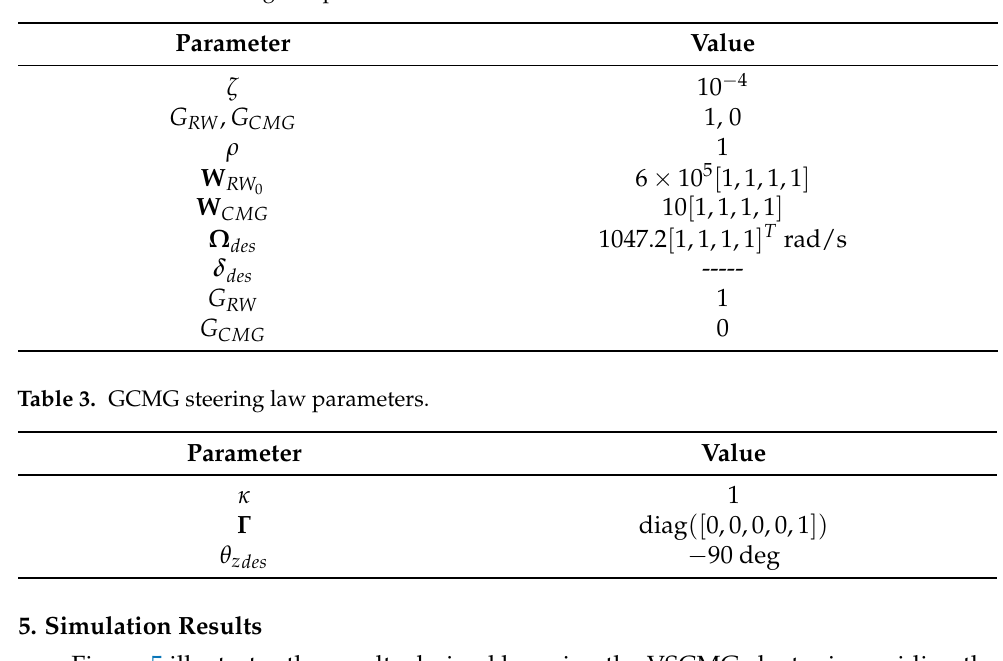
Table 2. VSCMG steering law parameters.